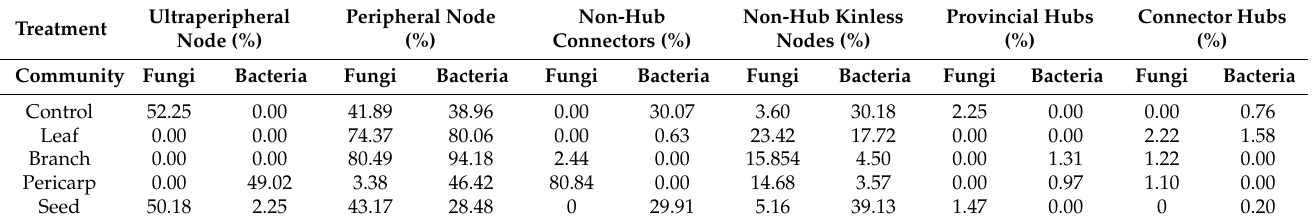
Table 2. Topological characteristics of the ecological networks of the fungal communities and their associated random networks for the topsoils in different